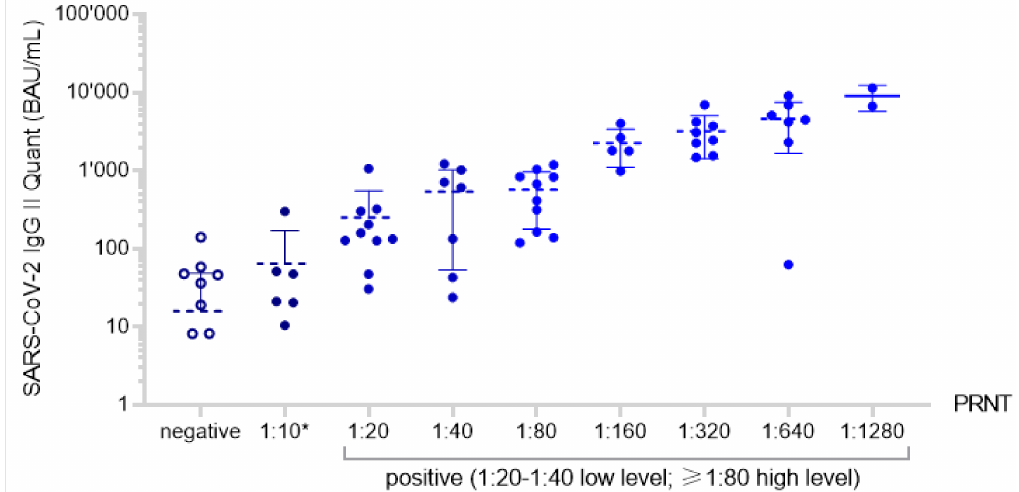
Figure 3. Distribution of SARS-CoV-2 IgG II Quant test results (BAU/mL) in relation to the results of the PRNT conducted in parallel, including mean and standard deviation bars. PRNT test results ≥ 1:10 are shown as filled data point symbols and negative results are shown as empty data point symbols. Fifteen samples were negative tested in the SARS-CoV-2 IgG II Quant as they did not generate a signal. As a result of the logarithmic scale of the y-axis, they are not depicted in the figure. * “borderline”